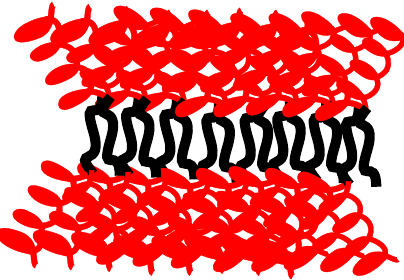
Figure 14. Schematic illustration of the cylindrical aggregates from the interaction of the initially formed spherical micelles.